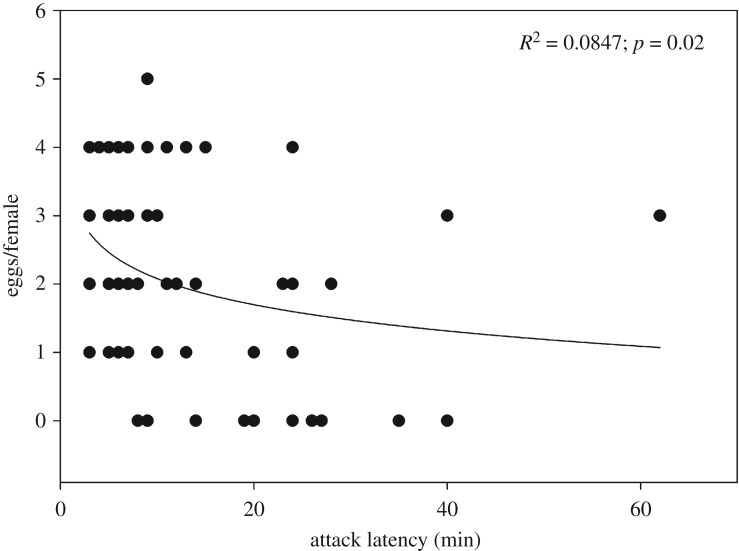
Number of eggs produced within 48 h regressed (logarithmic; y = a + b × ln(x)) on the attack latency by adult A. swirskii females offered six nymphs of T. urticae (TU) and six 1st larvae of F. occidentalis (FO) in the behavioural assay (experiment 1). During the preceding prey experience phase, the juvenile females received in their larval and early protonymphal stage either TU or FO or both, TU + FO, as 1st prey, and from the late protonymphal stage until adulthood either TU or FO as 2nd prey (table 1).